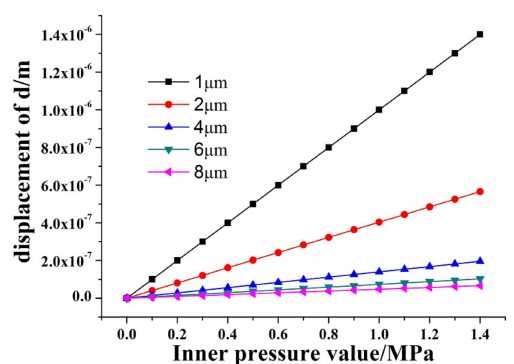
Figure 12. Relationship of bubble tip shift and iner pressure uder different wall thickness (from 1 to 8 µ